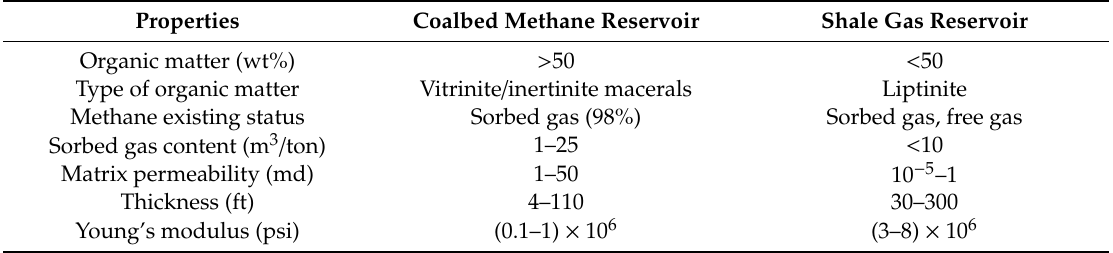
Table 3. Physio-chemical di ff erences of the coalbed methane reservoir and the shale gas